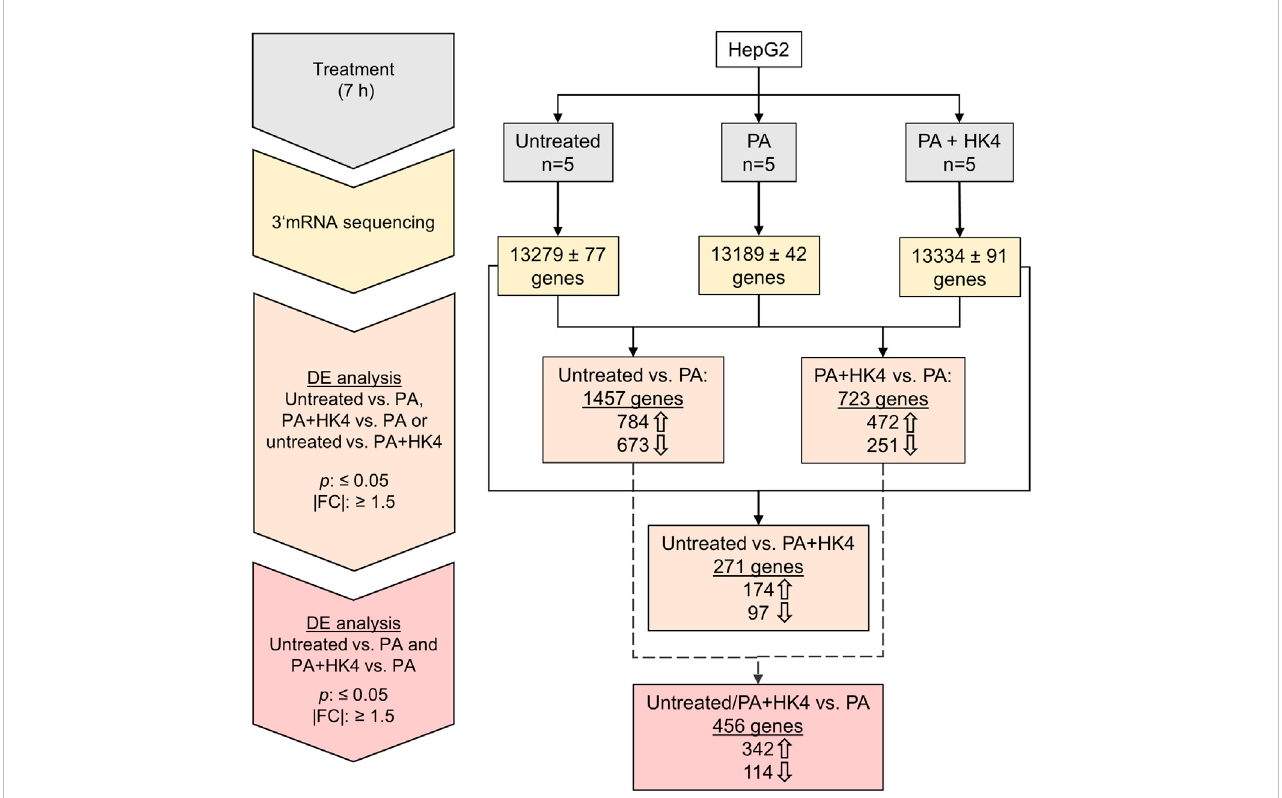
FIGURE 1 Work fl ow and overview of the number of genes in untreated, palmitate (PA) or PA + HK4-treated HepG2 cells. After 7 h treatment with 200 μ M PA and 10 μ MHK4,RNAhasbeenisolatedfrom fi veindependentHepG2celllysatespertreatmentgroupand3 ′